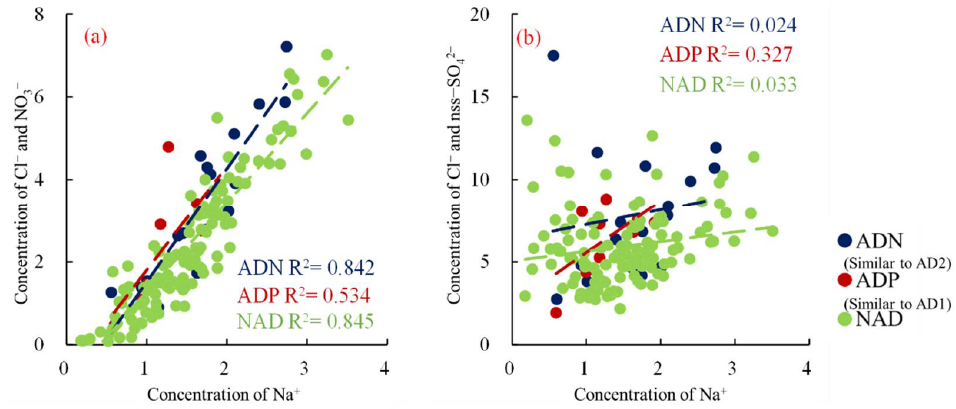
Figure 6. Linear regression of concentration of Na + with concentration of Cl − and NO 3− ( a ) and concentration of Cl − and nss-SO 4 2 − ( b ) during long-term observation from 2010 to 2015. ADN can be regard as similar to the situation of the AD2 event, ADP can be regarded as similar to the situation of the AD1 event.